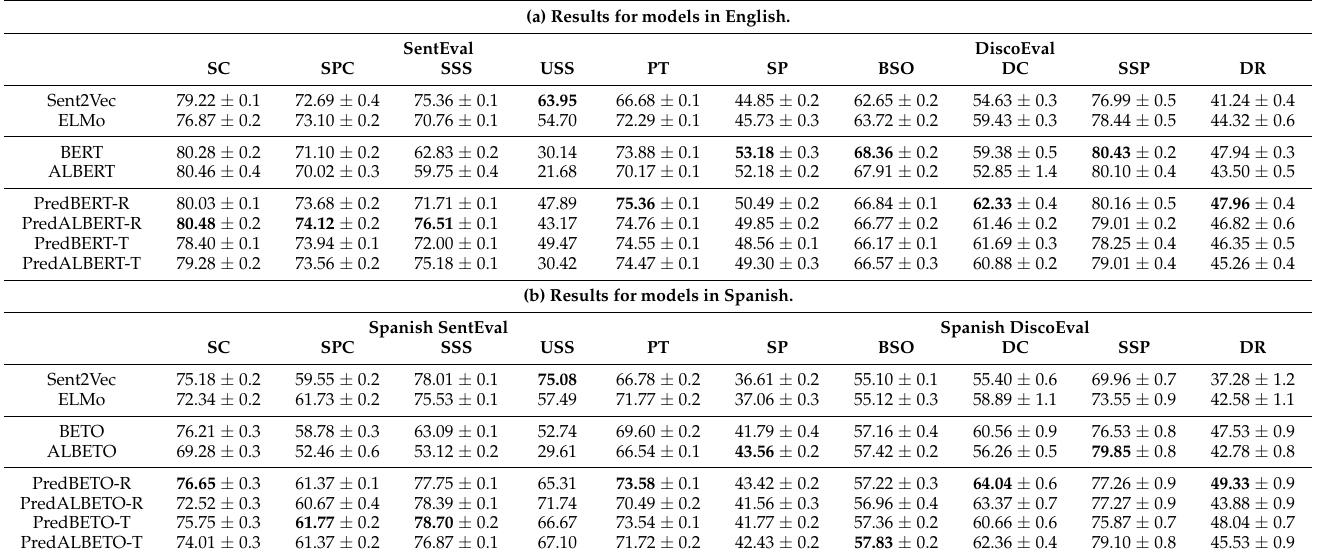
the experiment 10 times with different seeds and reported the average accuracy (Pearson’s correlation for SSS and USS) and standard deviations. Table 1. Results in SentEval and DiscoEval benchmarks in English and Spanish. The metric is accuracy except for SSS and USS, which is Pearson’s correlation. We report standard deviations by running the evaluations 10 times with different seeds.